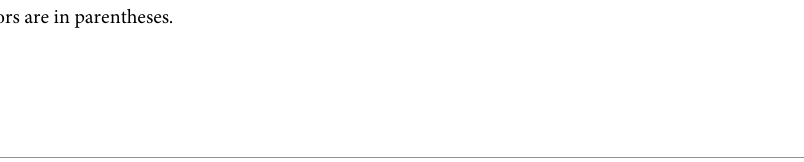
Table 2. The result of Granger causality test of quarterly year-on-year GDP growth rate and quarterly year-on- year CPI growth rate. H 0 Standard errors are in